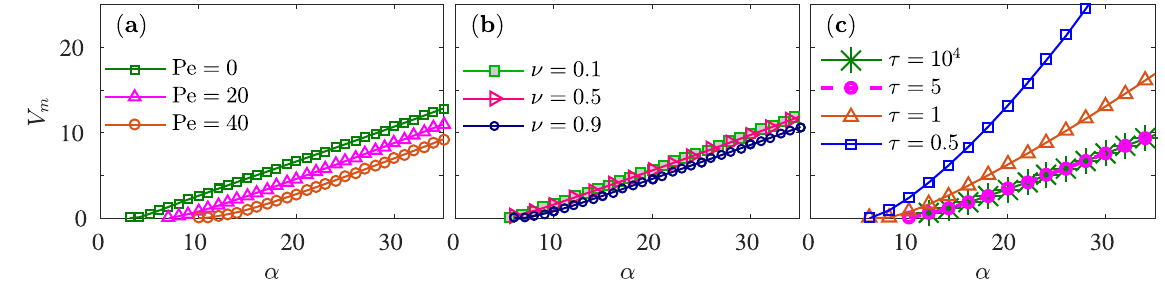
Figure 4. Dependence of non-dimensional migration velocity V m on lateral advection (parameterized by Pe , a ), far-field bed temperature (parameterized by ν , b ), and basal shear stress on subtemperate side of the bed (parameterized by τ , c ). Unless indicated otherwise, we used Pe = 10, ν = 0 . 5, and τ = ∞